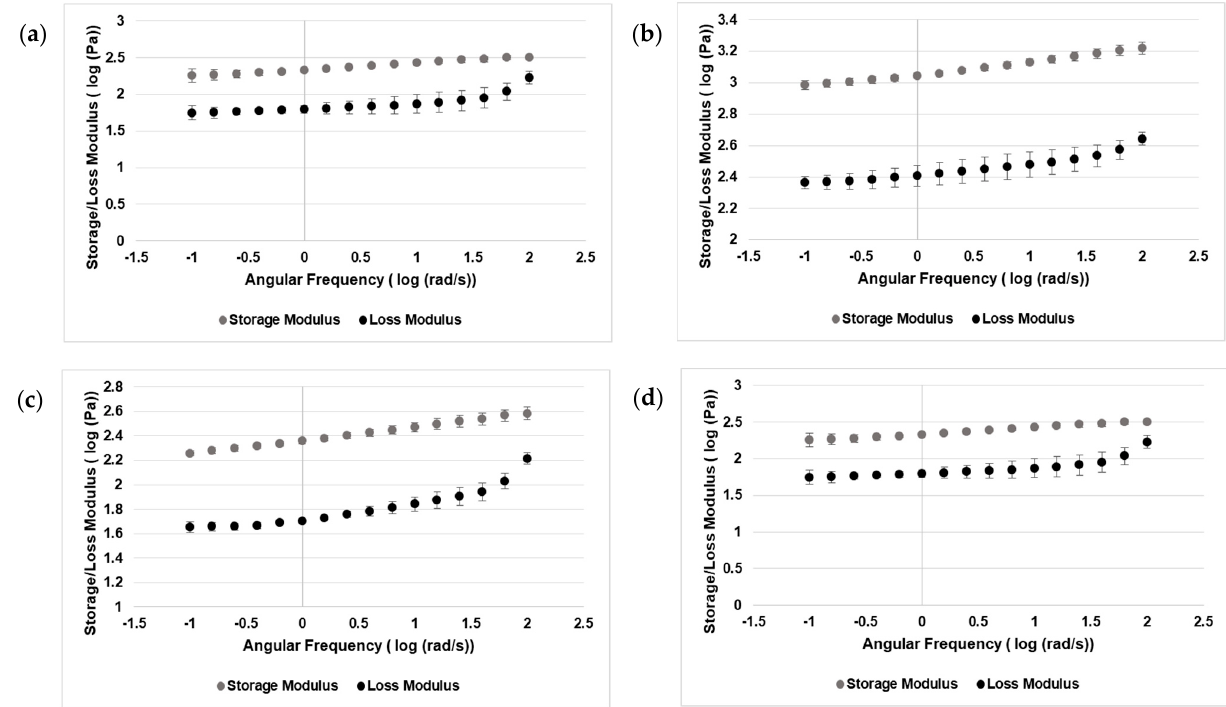
Figure 9. Rheological properties. ( a ) Storage and loss modulus of bioprinted constructs with microspheres. ( b ) Storage and loss modulus of bioprinted constructs without microspheres. ( c ) Storage and loss modulus of manually combined bioink and crosslinker. ( d ) Storage and loss modulus of manually combined bioink and crosslinker with microspheres.